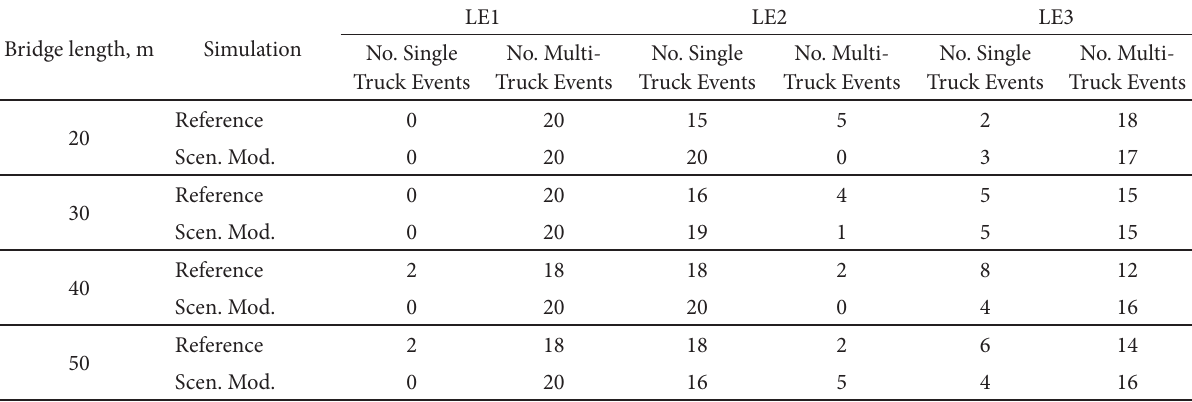
Table 4. Event types for the 20 greatest load effects for the reference microsimulation and Scenario Modelling traffic, for all bridge lengths and load effect types (LE1 = mid-span bending, LE2 = shear, LE3 = hogging moment over central support)